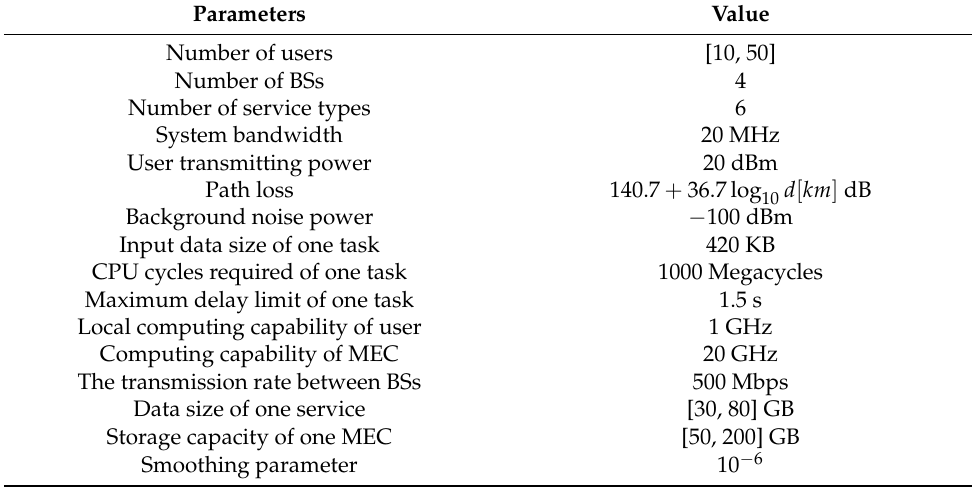
Table 2. Main Simulation